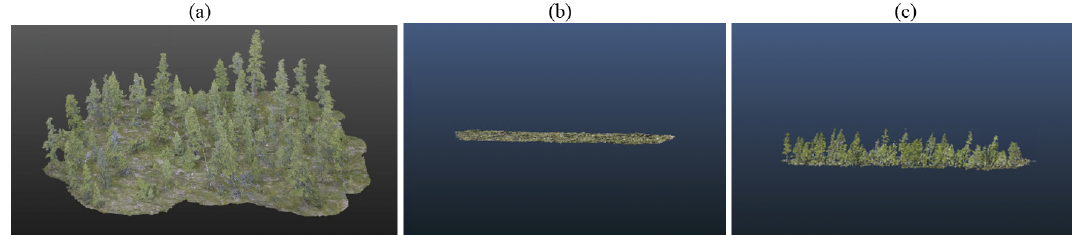
Figure 4. (a) Example of a full red–green–blue (RGB) structure-from-motion (SfM) point cloud for plot EN18074. Panel (b) shows the segmented RGB point cloud containing only the points of the ground layer, named groundonly and (c) shows the segmented RGB point cloud with the aboveground vegetation, named treesonly